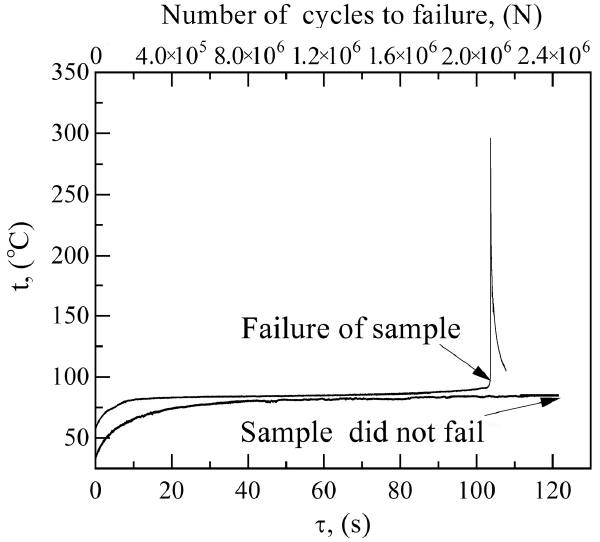
Figure 11. Maximal temperature change in the central area of the CG (1) and UFG (2) samples caused by cyclic loading (loading amplitude σ = 195 MPa) at room temperature.